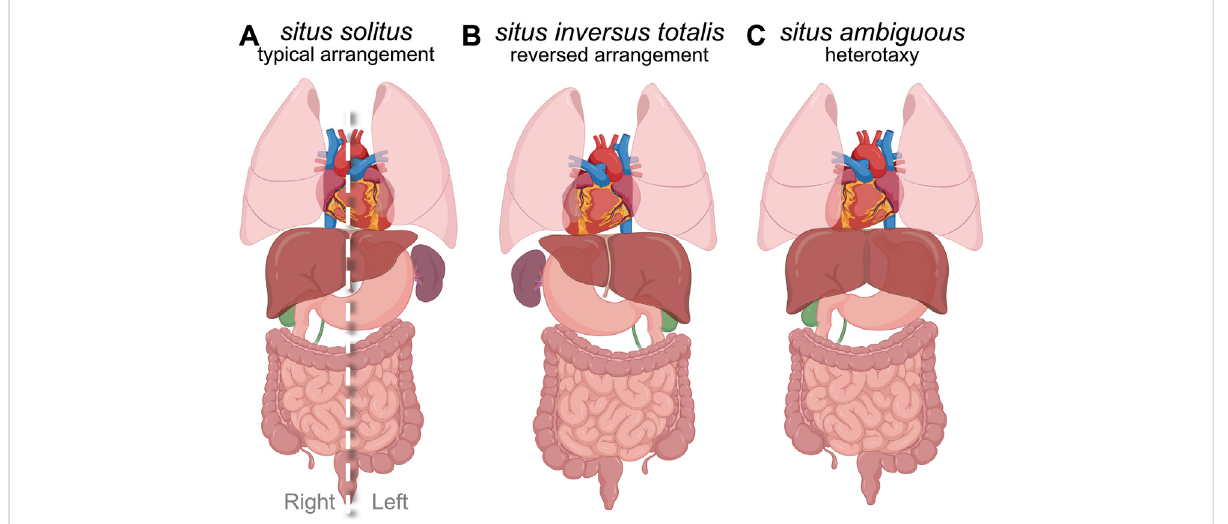
FIGURE 1 Human laterality and laterality disorders. (A) Diagram of situs solitus, which refers to the typical asymmetric development and arrangement of internalorgansalongtheleft-rightbodyaxis.Dashedlineindicatesthebodymidline. (B) Diagramof situsinversustotalis, whichisacompletemirror- image reversal of organ laterality. (C) Diagram of one example of situs ambiguous or heterotaxy (other arrangement). Situs ambiguous is associated with a broad range of birth defects of the cardiovascular and gastrointestinal systems.